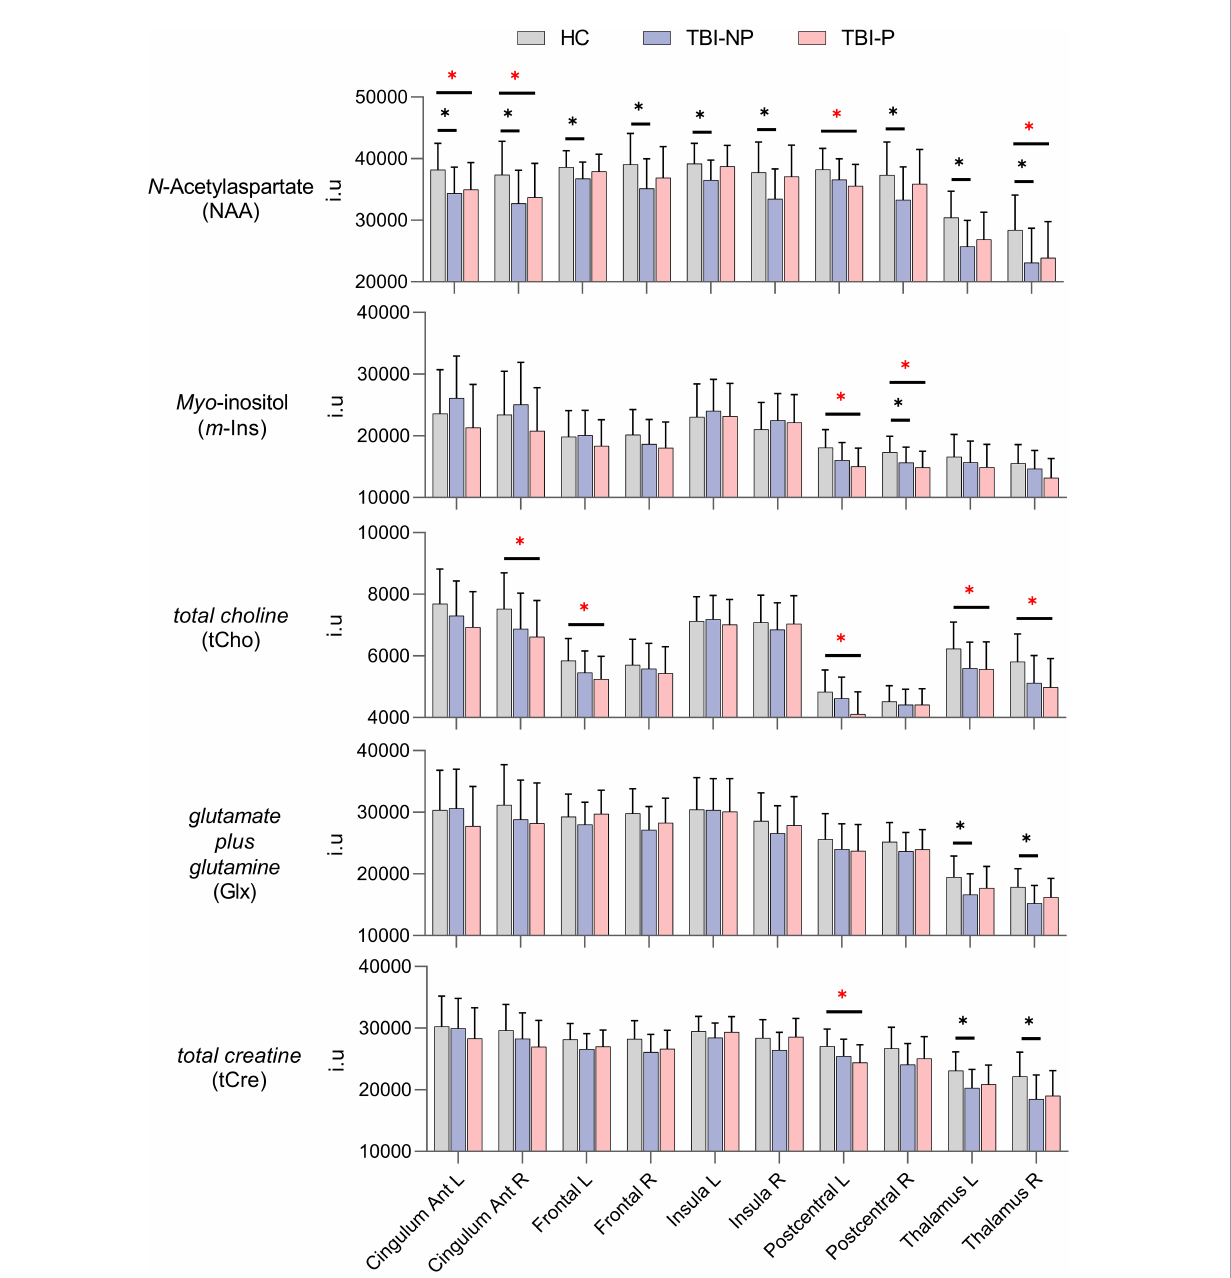
FIGURE2 Mean values of the metabolites in the healthy control (HC, N = 31), traumatic brain injury with no chronic pain (TBI-NP, N = 17), and traumatic brain injury with chronic pain (TBI-P, N = 16) groups, by brain region, with error bars indicating the standard deviation (SD). False discovery rate (FDR)-corrected significant differences indicated with asterisks ( ∗ p ≤ 0.05). Red asterisks ( ∗ ) indicate significant differences between TBI-P and other groups. The y -axis scale is in institutional units (i.u.). Abbreviations used for the hemispheric regions: R, right and L, left; Ant,